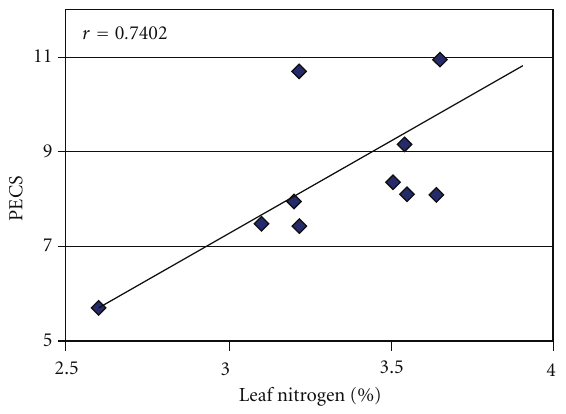
Figure 1: Corelation between PECS and leaf